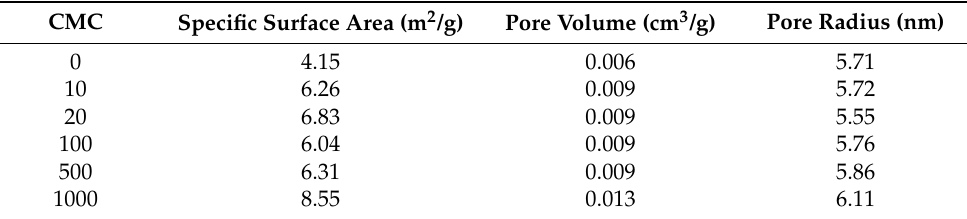
Table 2. BET analysis of biphasic calcium phosphate prepared by cuttlebone with variation of the CMC of L-rhamnose monohydrate biosurfactant.